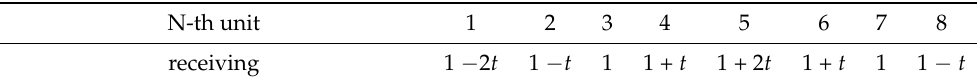
Table 2. Relative amplitude coefficients of the receiving array (forst